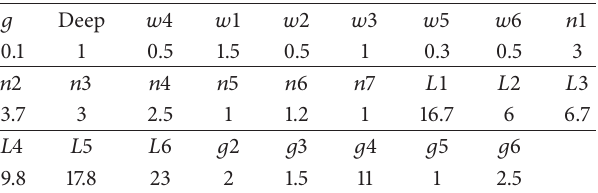
Table 1: Geometric parameters for the proposed MIMO antenna (unit: